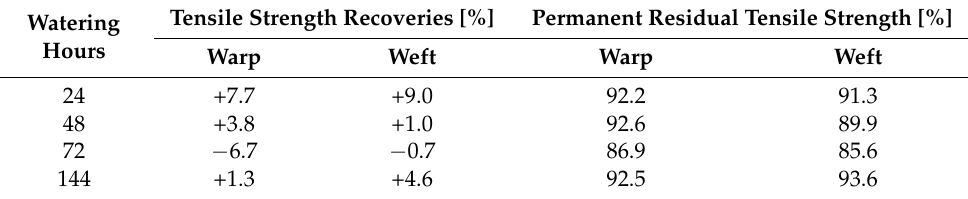
( b ) Figure 13. Permanent and temporary stress–strain curves after 24 h of watering, glass-PTFE type II first batch according to Table 3: ( a ) warp direction and ( b ) weft direction. Continuous lines: temporary changes, dashed lines: permanent changes.